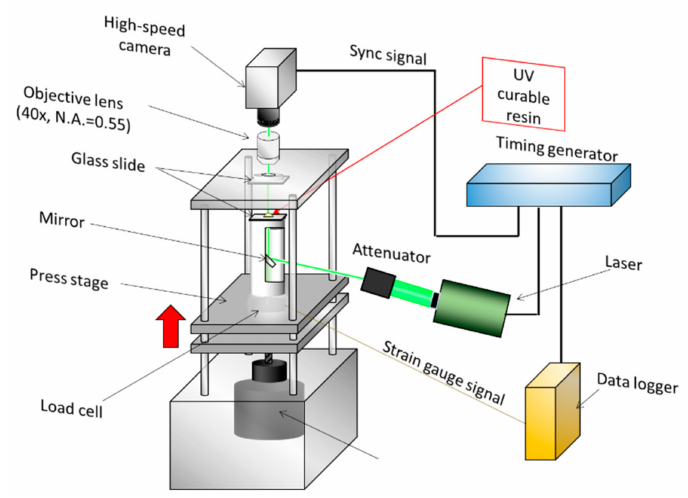
Figure 2. DHPTV setting for squeezed flow in a UV nanoimprint process [44].